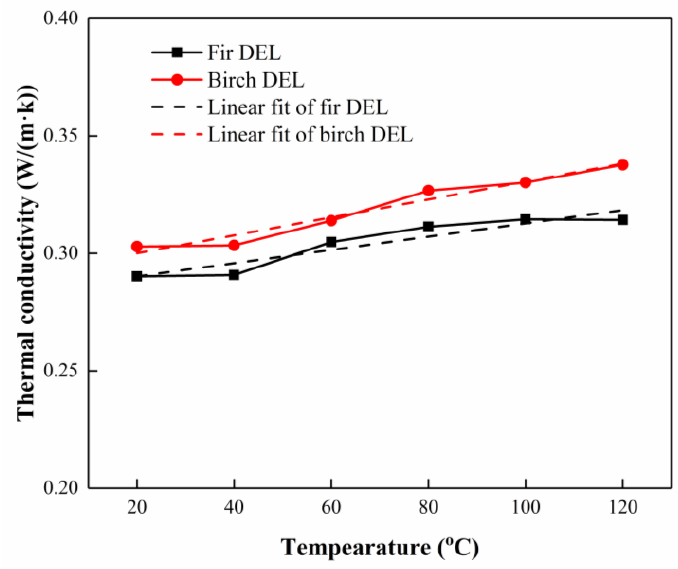
Figure 5. Thermal conductivities of Chinese fir DEL and birch DEL.